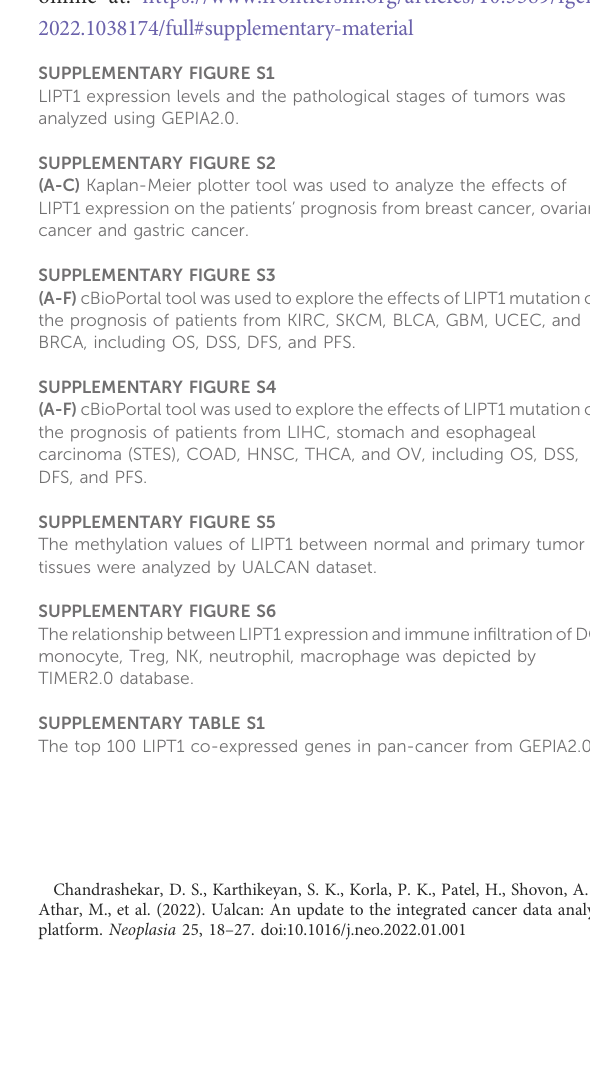
SUPPLEMENTARY FIGURE S1 LIPT1 expression levels and the pathological stages of tumors was analyzed using GEPIA2.0. SUPPLEMENTARY FIGURE S2 (A-C) Kaplan-Meier plotter tool was used to analyze the effects of LIPT1 expression on the patients ’ prognosis from breast cancer, ovarian cancer and gastric cancer. SUPPLEMENTARY FIGURE S3 (A-F) cBioPortaltoolwasusedtoexploretheeffectsofLIPT1mutationon the prognosis of patients from KIRC, SKCM, BLCA, GBM, UCEC, and BRCA, including OS, DSS, DFS, and PFS. SUPPLEMENTARY FIGURE S4 (A-F) cBioPortaltoolwasusedtoexploretheeffectsofLIPT1mutationon the prognosis of patients from LIHC, stomach and esophageal carcinoma (STES), COAD, HNSC, THCA, and OV, including OS, DSS, DFS, and PFS. SUPPLEMENTARY FIGURE S5 The methylation values of LIPT1 between normal and primary tumor tissues were analyzed by UALCAN dataset. SUPPLEMENTARY FIGURE S6 TherelationshipbetweenLIPT1expressionandimmunein fi ltrationofDC, monocyte, Treg, NK, neutrophil, macrophage was depicted by TIMER2.0 database. SUPPLEMENTARY TABLE S1 The top 100 LIPT1 co-expressed genes in pan-cancer from